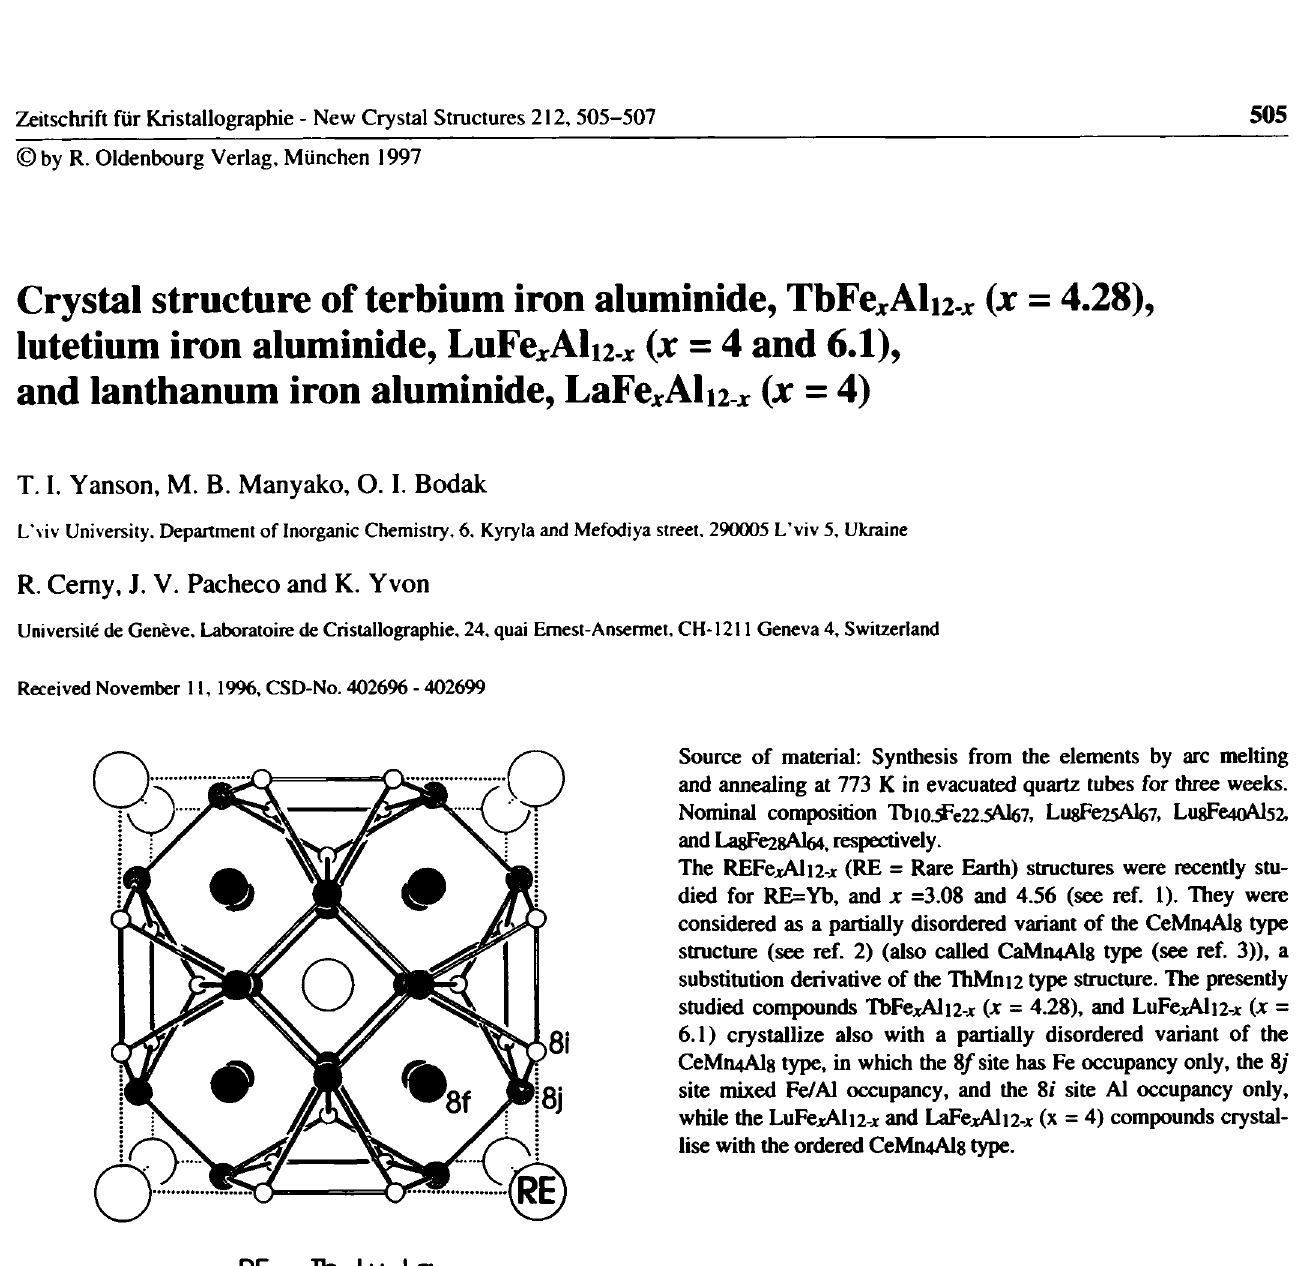
Table 1. Parameters used for the X-ray data collection Crystal: